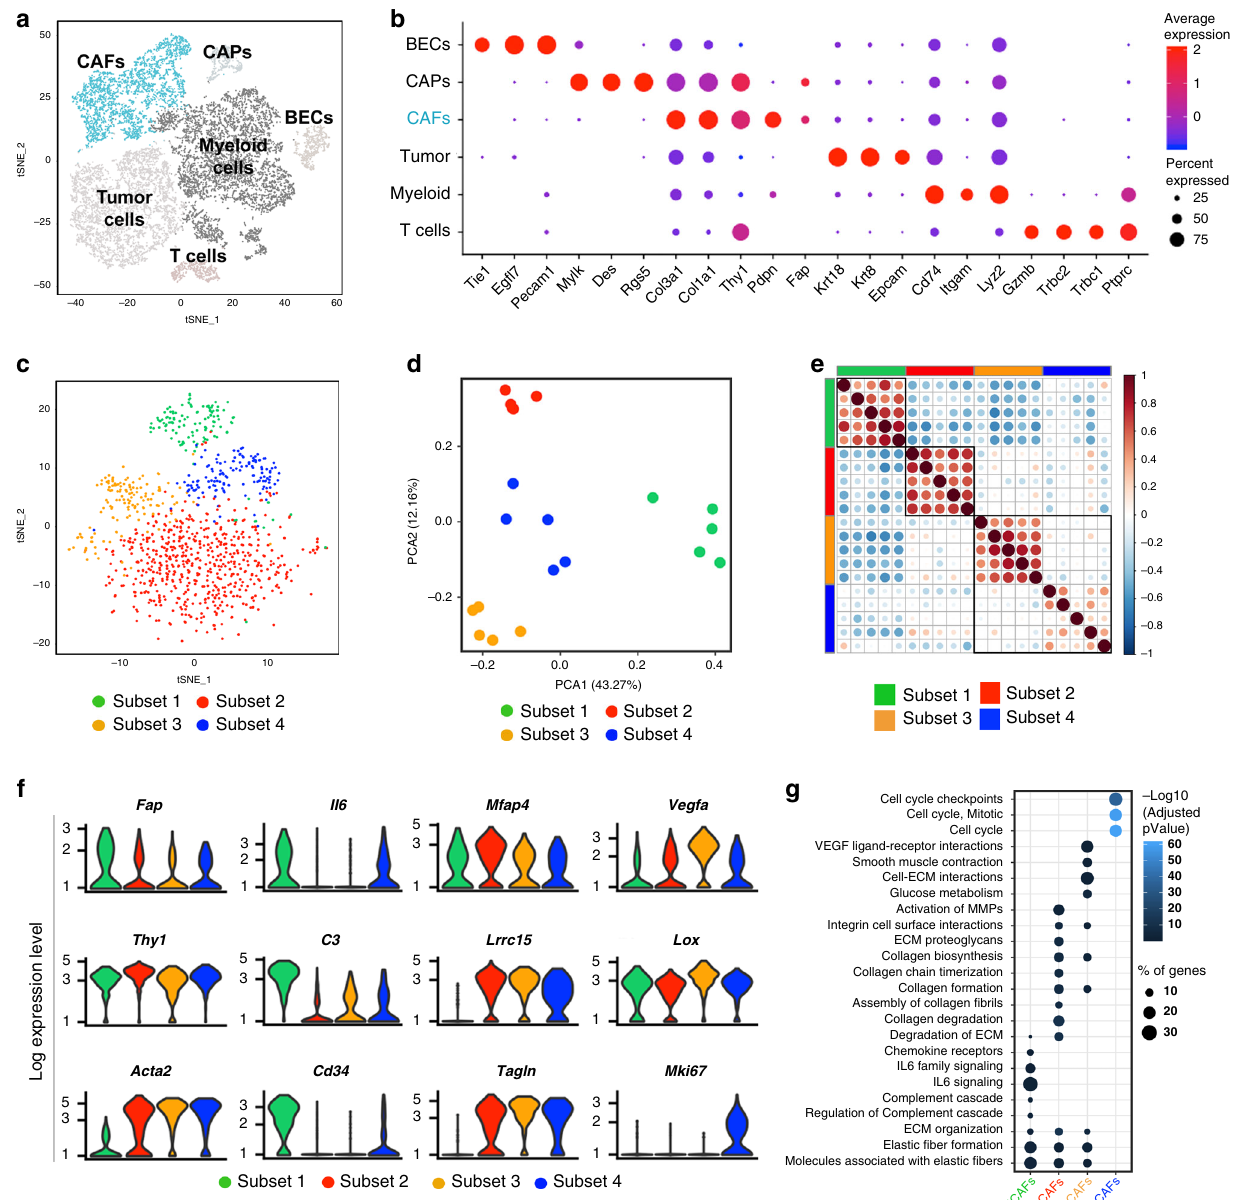
Fig. 1 Phenotypic and functional heterogeneity of CAFs. a t-SNE plot of single cell RNAseq data generated from 4T1 tumors. The cluster identi fi ed as CAFs is highlighted in teal. b Bubble plot outlining the expression of canonical lineage cell markers utilized for cell cluster annotation. c CAF-only t-SNE projection showing emergent sub-clusters. d Biplot of Principle Components 1 and 2 from analysis of genes with highest variability (s.d. > = 5), each dot represents a CAF subset from one of fi ve independent samples. e Pearson correlation analysis of CAF subsets from each sample. f Violin plots depicting log expression level of selected genes. g Pathway enrichment analysis was performed on genes differentially expressed by each CAF subset using gPro fi ler (log (FC) > 1, Reactome pathways with p -value <0.05 were selected for, Fisher ’ s one-tailed test was used to calculate p -values, and p- values were adjusted for multiple testing). n = 5 samples from 3 independent